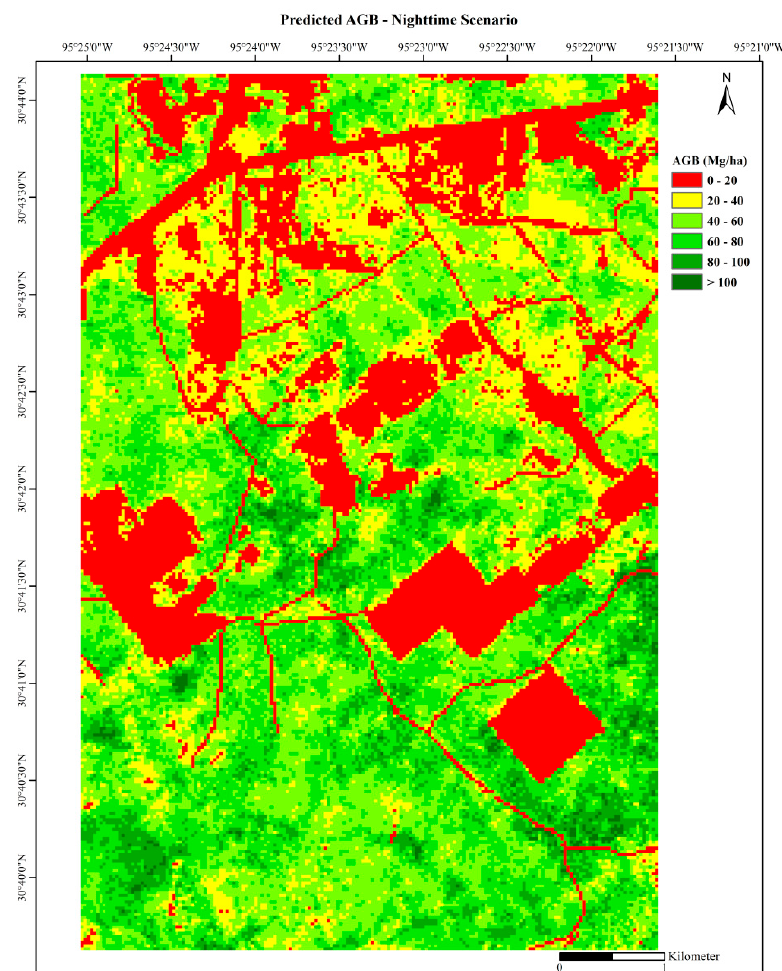
Figure 7. DNN predictions of AGB density at a 30 m spatial resolution for the nighttime scenario.